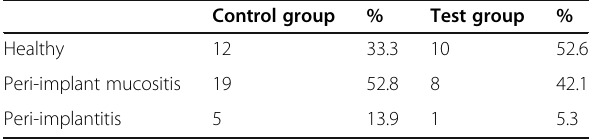
Table 3 Prevalence of peri-implant disease (patient level) Control group %